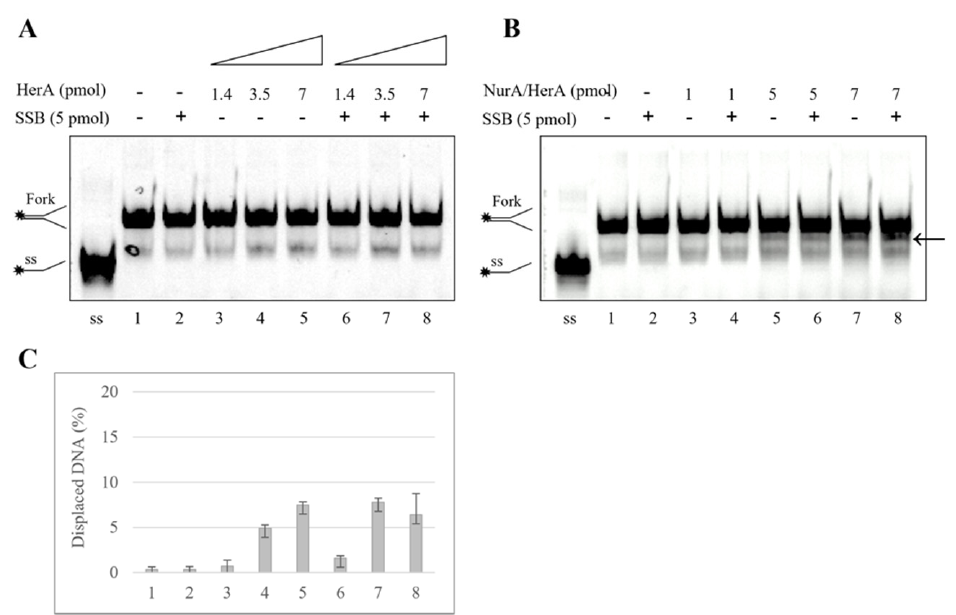
Figure 7. Helicase activity of HerA or NurA/HerA complex on a 70 merCy5 forked substrate. ( A ) Increasing amounts of HerA (from 1,4 to 7 pmoles) were analyzed for helicase activity in absence (lanes 3–5) and presence (lanes 6–8) of 5 pmoles of SSB. ( B ) Increasing amounts of NurA/HerA complex (from 1 to 7 pmoles) were analyzed for helicase activity in absence (lanes 3, 5 and 7) and presence (lanes 4, 6 and 8) of 5 pmoles of SSB. Lanes 1 and 2 are negative controls in which no proteins and only SSB were used in the reaction, respectively. ss refers to 70 merCy5 single-strand oligonucleotide migration. The arrow indicates the degradation products due to NurA nuclease activity. ( C ) The gels have been quantified as reported in Materials and Methods, and the average of three different experiments is reported.